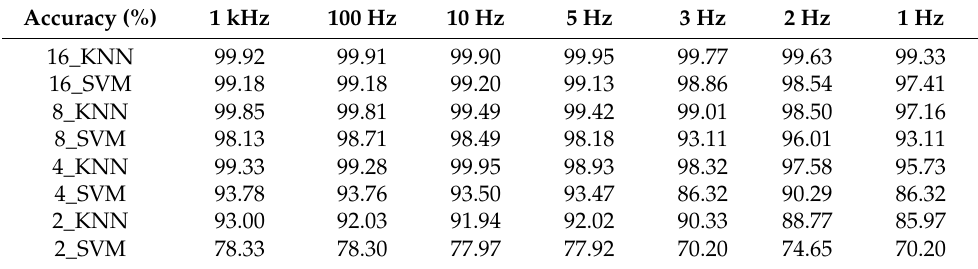
Table 3. Hand gesture classification accuracy by KNN and SVM under different combination of channel number and sampling frequency, where 8_KNN as an example indicates using 8 channels and KNN classifier.